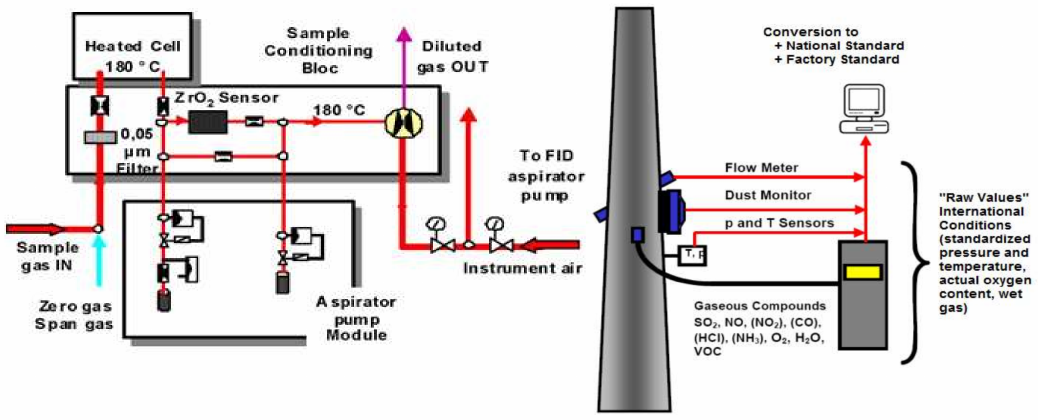
Figure 2. Simplified scheme and component elements of the sampling system for the clinker kiln emission evacuation